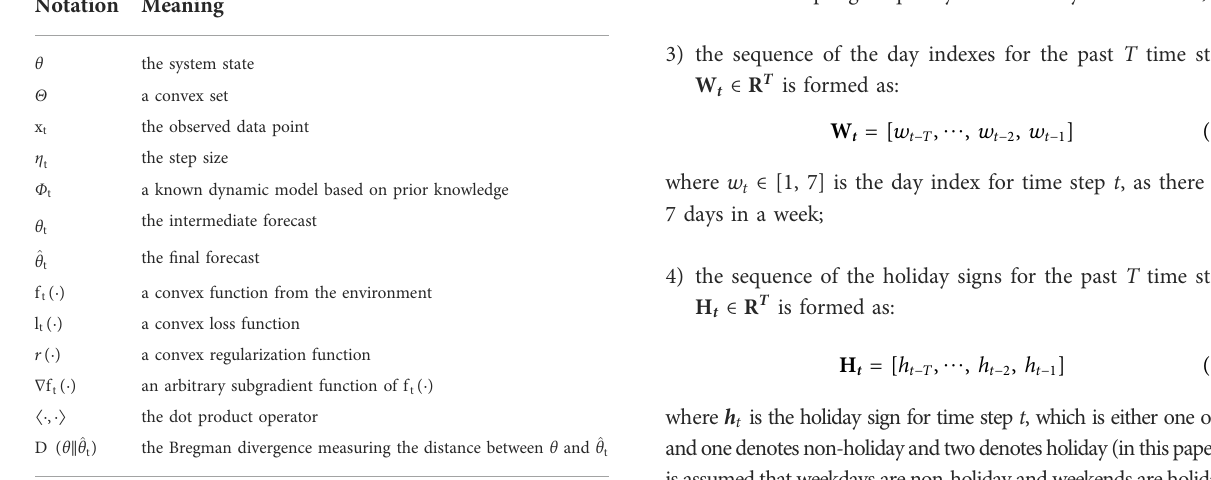
TABLE 1 Frequently used notations in dynamic mirror